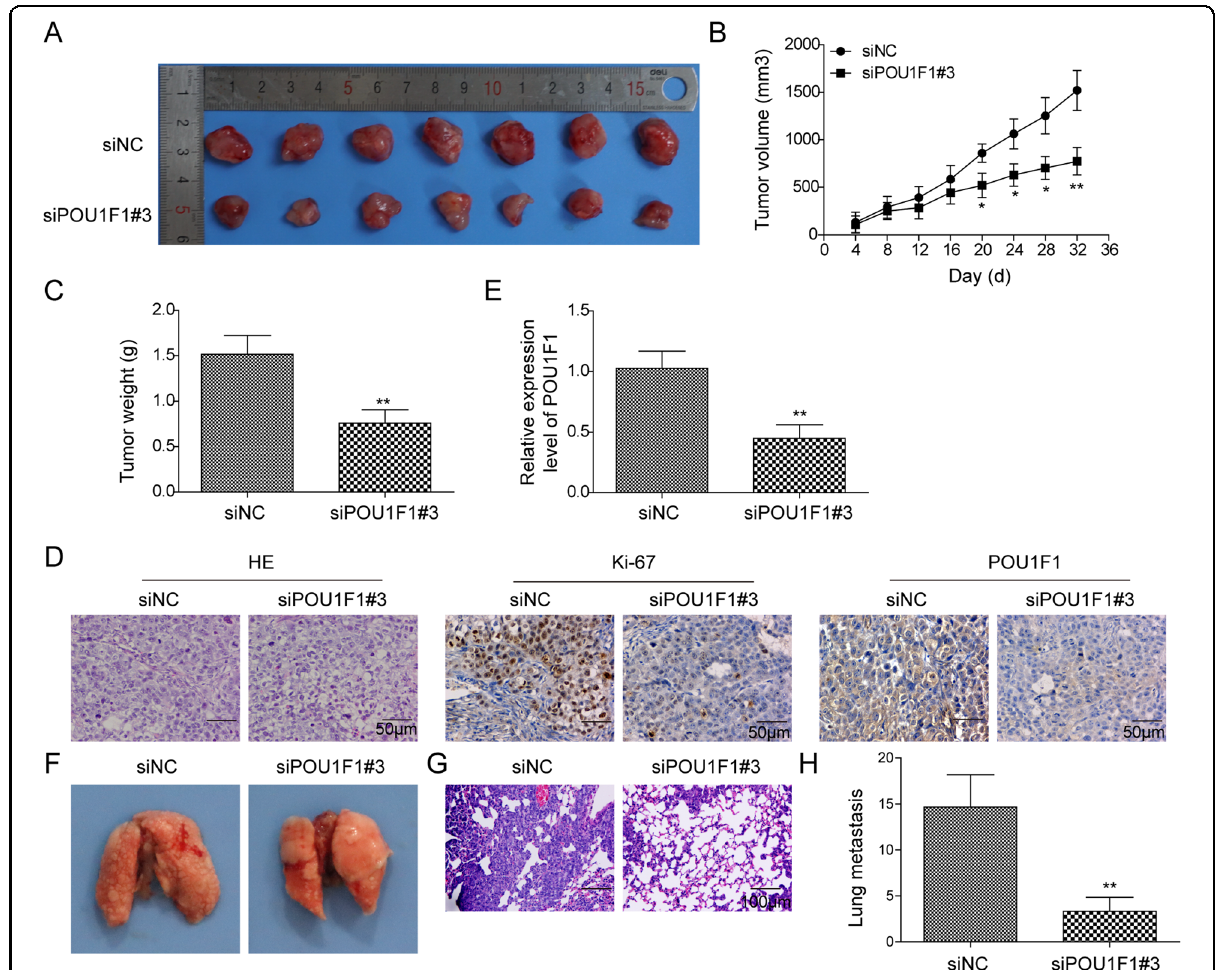
Fig. 3 Knockdown of POU1F1 inhibits tumor growth and metastasis in vivo. A The photos of xenograft tumors. B Quantitative analysis of tumor size. C Quantitative analysis of tumor weight. D Histopathological analysis of xenograft tumors. The histopathological changes were determined by H&E staining. The immunoreactivities of POU1F1 and Ki67 were assessed by IHC analysis. E The mRNA level of POU1F1 in xenograft tumors were determined by qRT-PCR. GAPDH served as an internal control. F The photos of lung tissues. G Histopathological analysis of metastatic nodules in lung. The histopathological changes were determined by H&E staining. H Quantitative analysis of metastatic nodule numbers. Data were representative images or were expressed as the mean ± SD of n = 3 experiments. * P < 0.05, ** P <